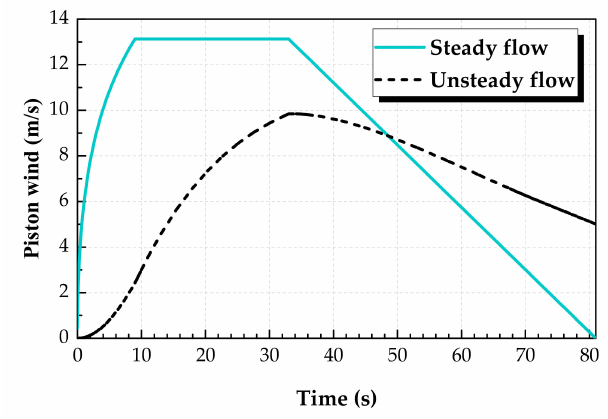
Figure 8. Comparison between the steady flow calculation result and the unsteady flow calculation